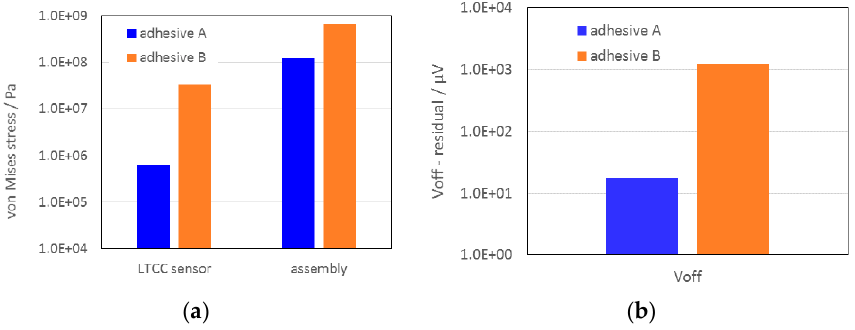
Figure 7. Results of FEA of the 100-mbar LTCC sensor glued with adhesive A and B: ( a ) maximum von Mises stresses in the LTCC structure; ( b ) the resulting offset voltage.